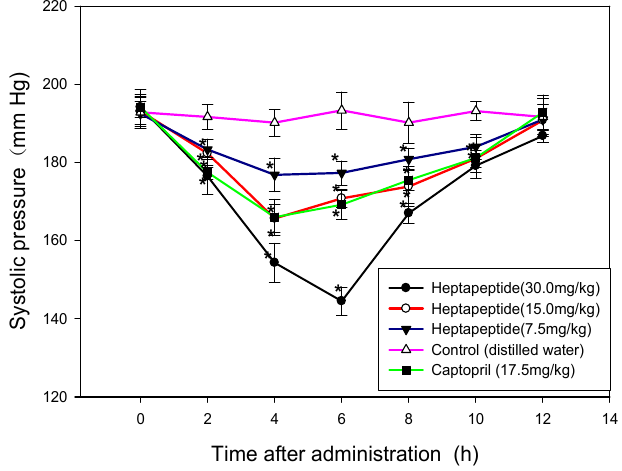
Figure 4. Change of systolic blood pressure (SBP) after oral administration of GAAGGAF in spontaneously hypertensively rats (SHR). Each point on the figure represented mean SBP of six animals and the vertical bars indicated the standard errors. Significant different from control group: * p < 0.05.